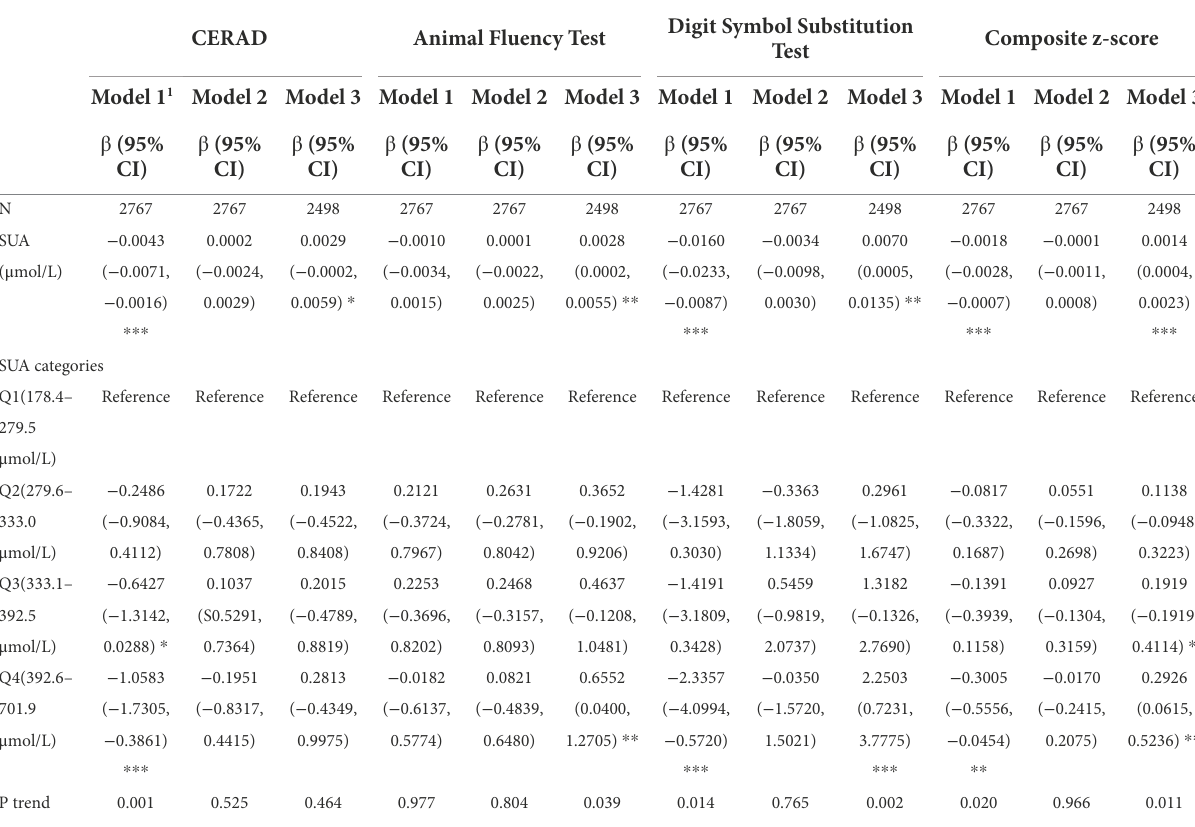
TABLE 2 Association between SUA ( μ mol/L) and cognitive function. CERAD Animal Fluency Test